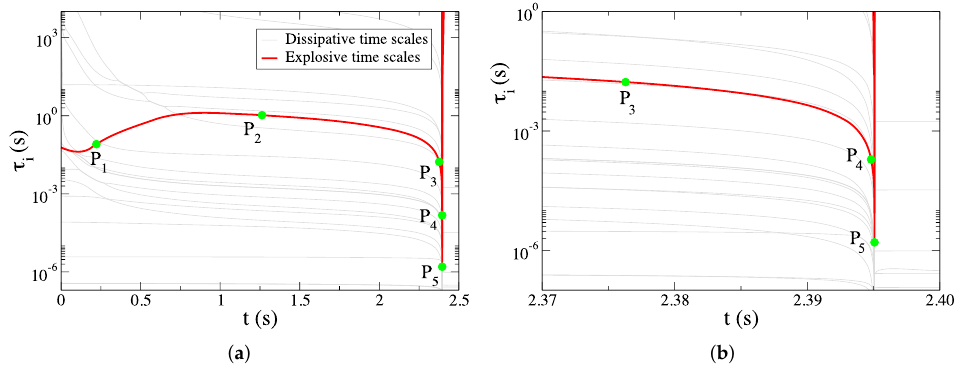
Figure 2. The five selected points in time where the diagnostics were obtained:: ( a ) the full explosive stage, ( b ) the final part of the explosive